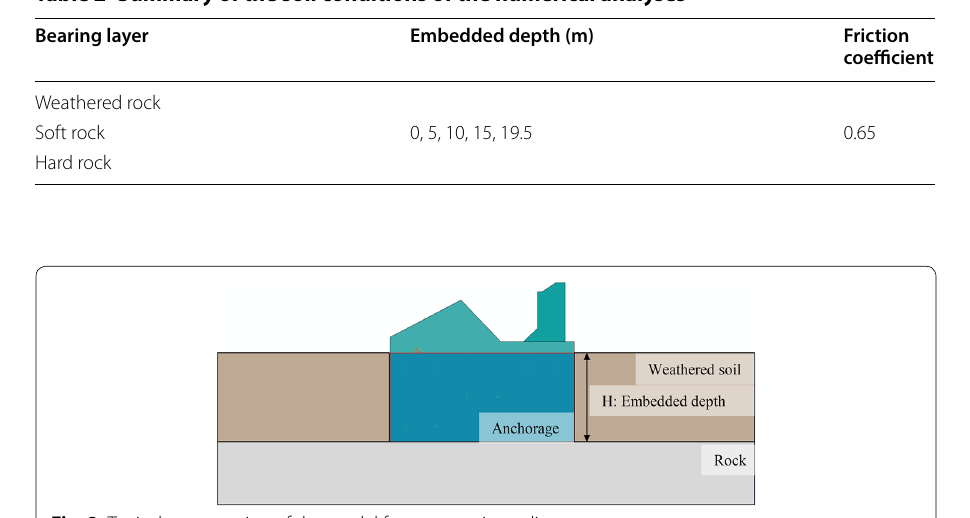
Fig. 2 Typical cross-section of the model for parametric